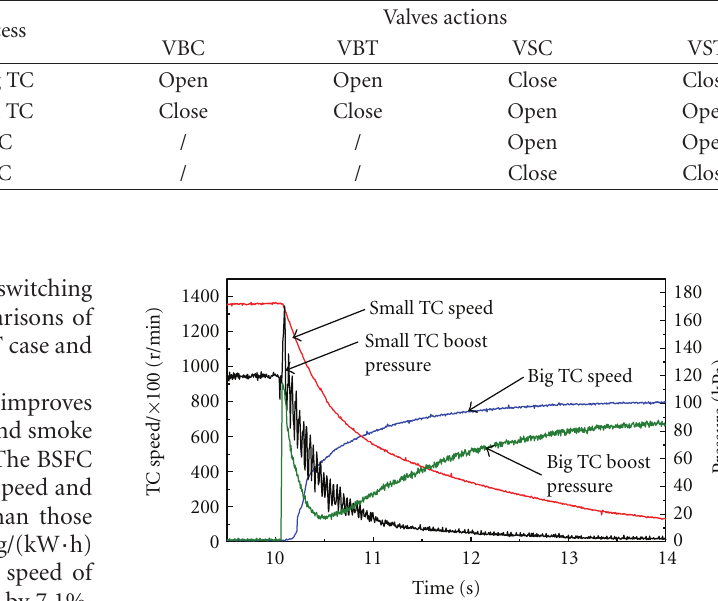
Table 2. The four valves are all butterfly valves